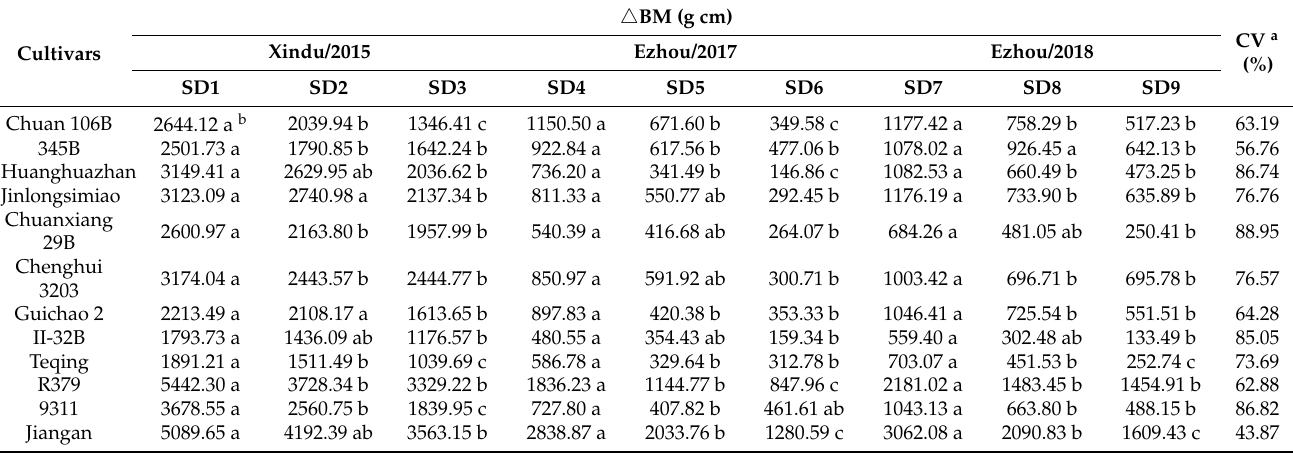
Table 3. The (cid:52) BM of twelve indica rice cultivars on all the sowing dates across two locations and three